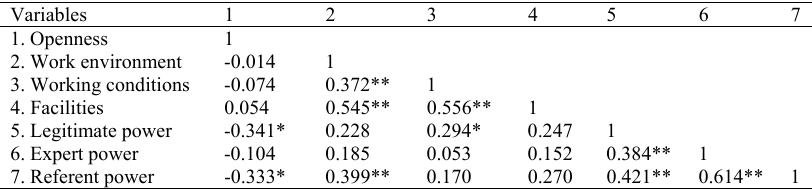
Table 6: Correlation analyses of personality, quality of work life and sources of leader power Variables